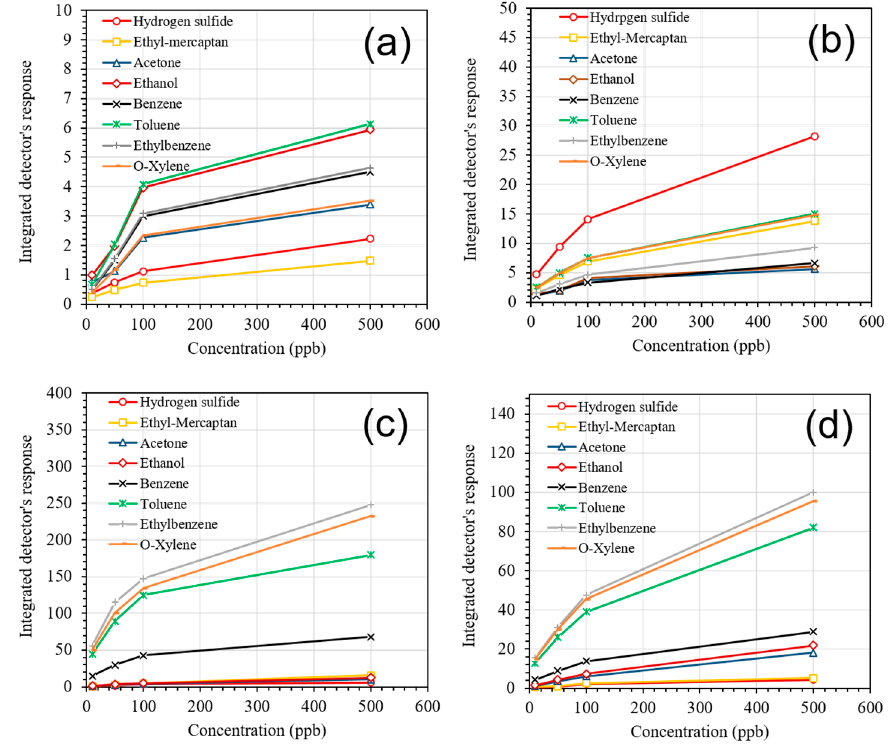
Figure 9. Calibration curves for ( a ) SnO 2 , ( b ) TiO 2 –SnO 2 , ( c ) Au/Pd@SnO 2 , and ( d ) Pt@SnO 2 , obtained